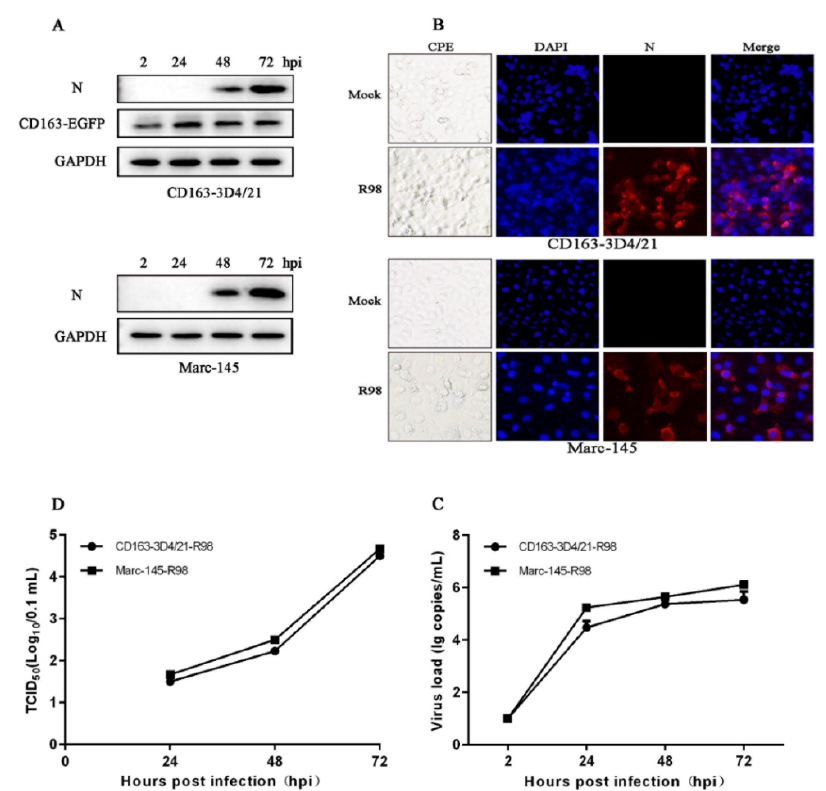
Figure 4. Growth of classical PRRSV2 strain R98 (lineage 5) on 3D4/21 cells stably expressing porcine CD163. ( A ) The CD163-3D4/21 cells and MARC-145 cells seeded in 24-well plates were infected with PRRSV R98 at an MOI of 0.1, for the indicated time points, followed by Western blotting. ( B ) The infected cells were observed for PRRSV specific CPE and fixed at 48 hpi followed by IFA using PRRSV N specific mAb (15A1). ( C , D ) The ORF7 transcriptions and viral titers of PRRSV R98 in CD163-3D4/21 cells and MARC-145 cells within 72 hpi were determined by SYBR Green real-time RT-PCR ( C ) and TCID50 assay ( D ), respectively.